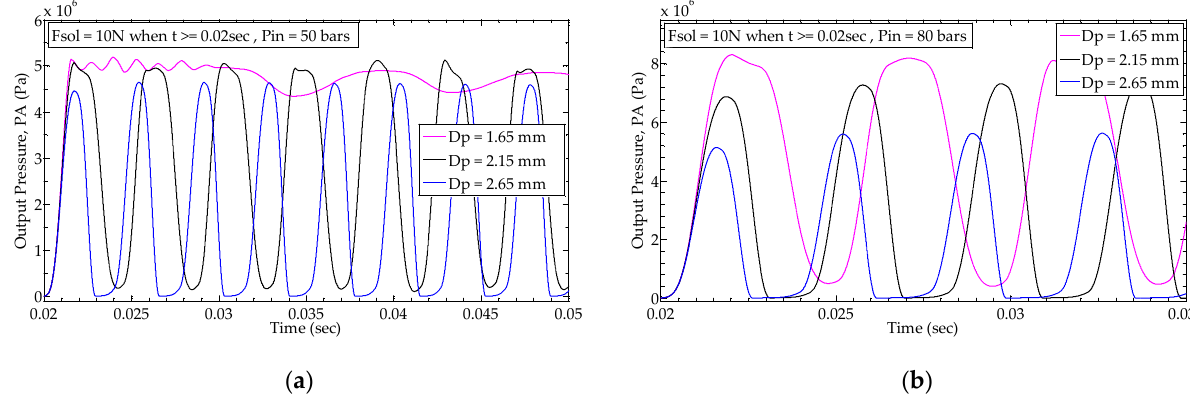
Figure 8. Comparison of output pressure for two different inlet pressures with same actuating force: ( a ) When inlet pressure is 50 bar; ( b ) When inlet pressure is 80 bar.